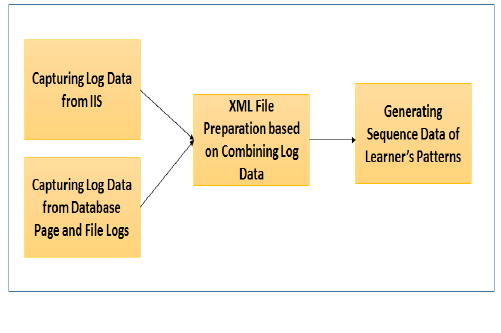
Figure 1. Web Log Analysis